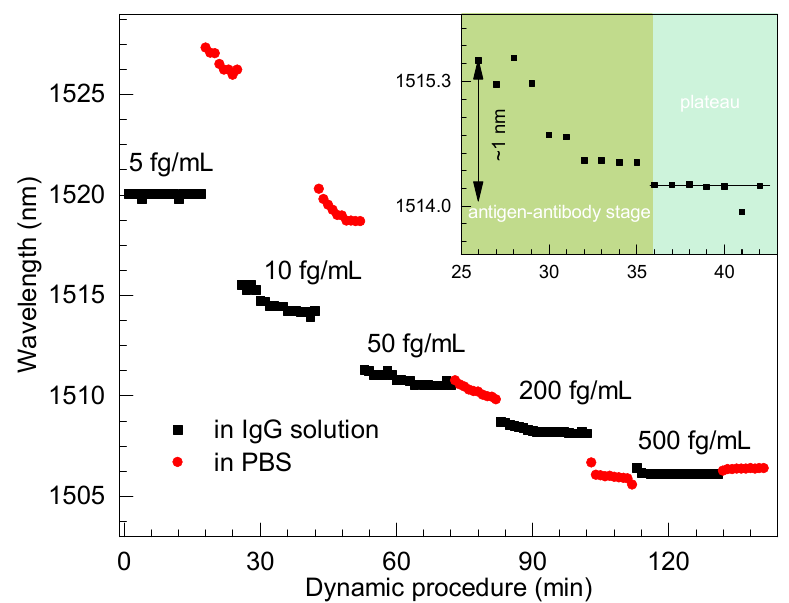
Figure 7. Spectral shift of the biosensor at different stages of IgG binding events.